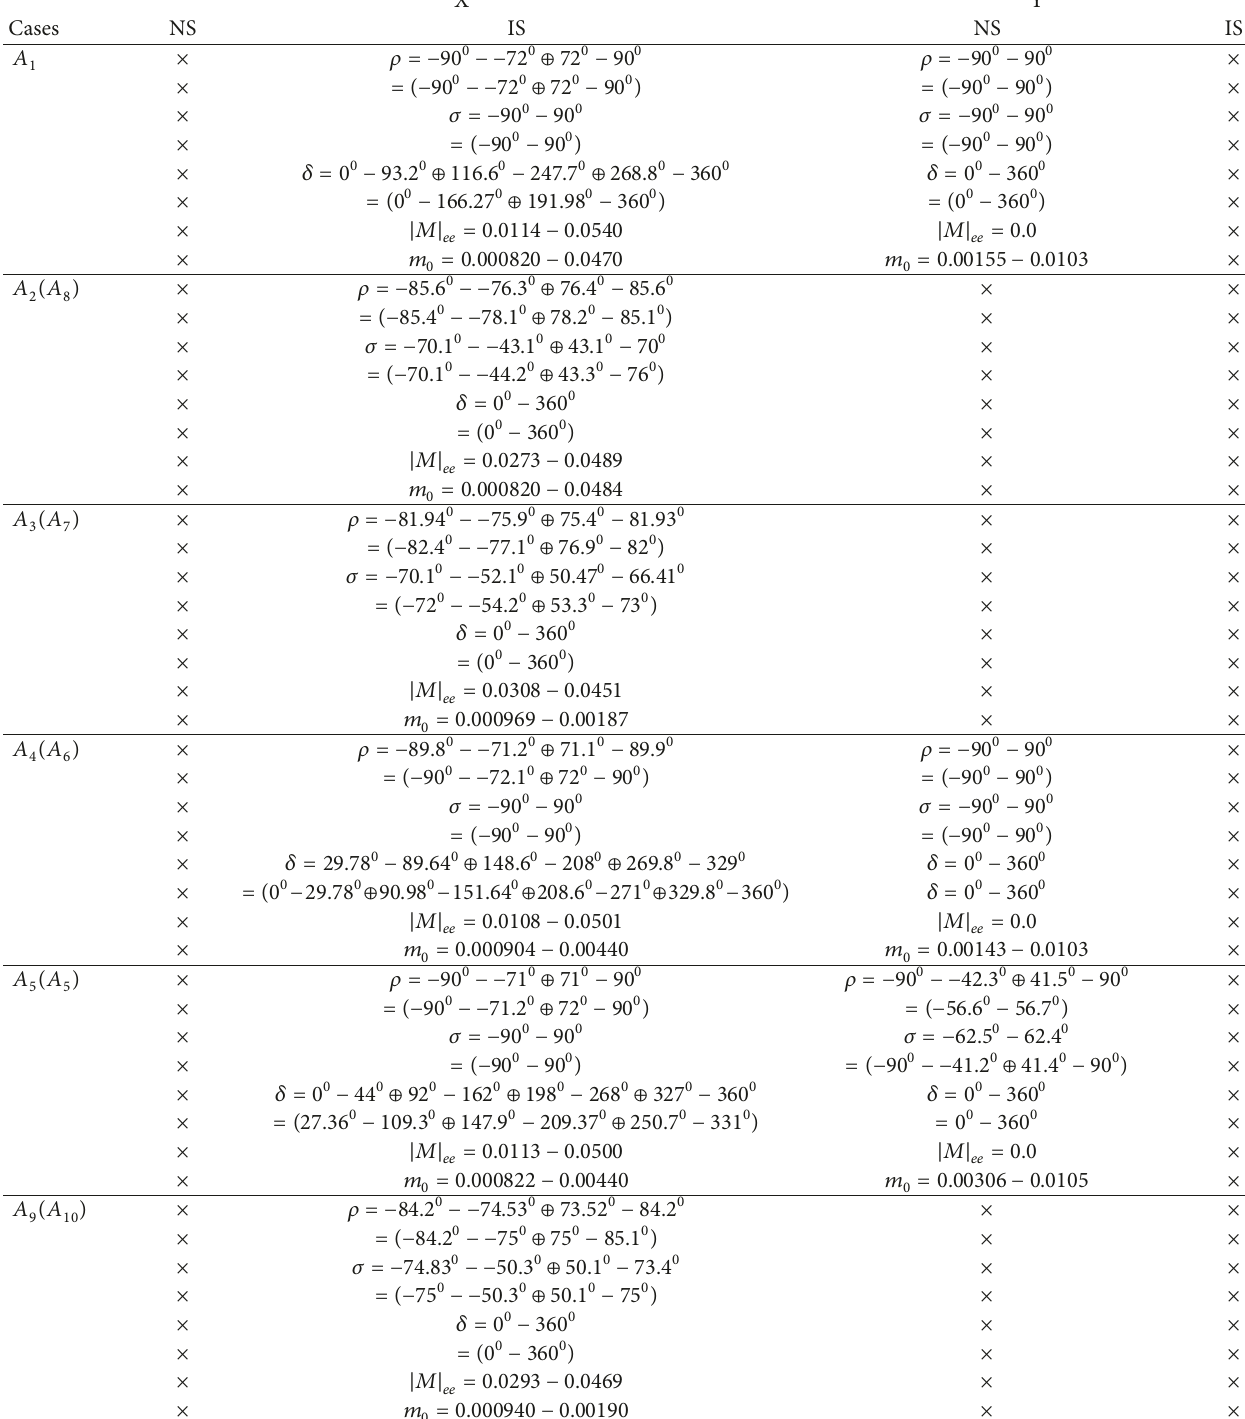
Table 3: The allowed ranges of Dirac CP-violating phase 𝛿 , the Majorana phases 𝜌, 𝜎 , effective neutrino mass |𝑀| 𝑒𝑒 , and lowest neutrino mass 𝑚 0 for the experimentally allowed cases of Category A at 3 have been put into